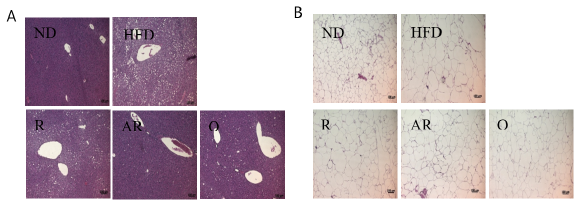
Figure 1. Histological analysis of liver ( A ) and epididymal ( B ) tissue in mice fed with experimental diets for 7 weeks. ND, normal diet; HFD, high-fat diet; R, high-fat diet with 100 mg/kg rutin/day; AR, high-fat diet with 100 mg/kg acid-treated rutin/day; Q, high-fat diet with 100 mg/kg quercetin/day.